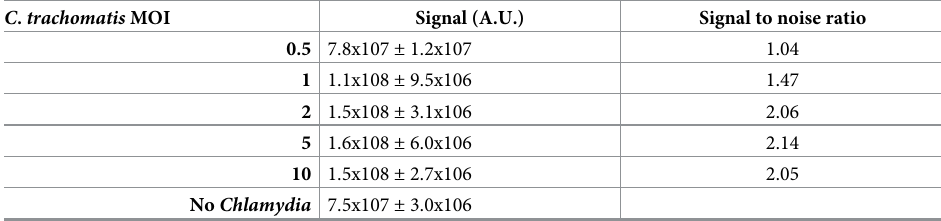
Table 2. Determination of the appropriate C . trachomatis MOI to be used in anti-chlamydial drug